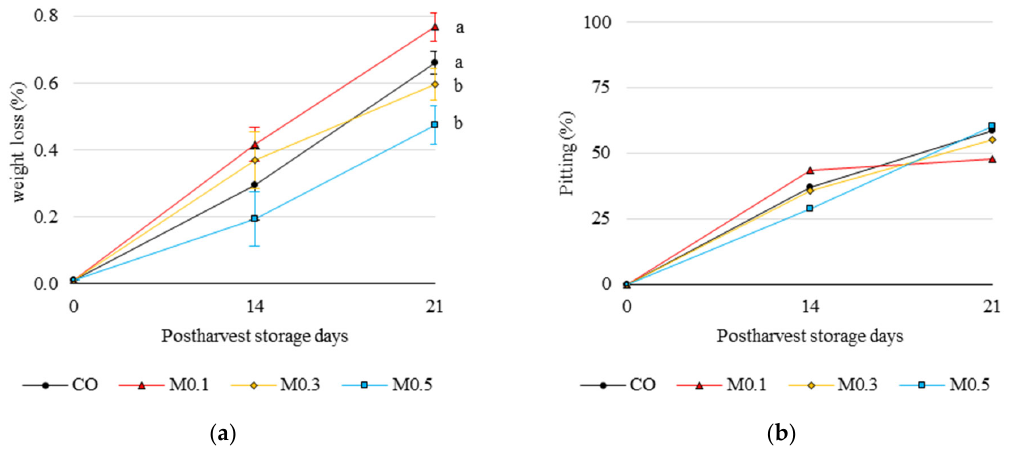
Figure 3. ( a ) Weight loss (%) of ‘Samba’ cherries in relation to treatments and storage time. ( b ) Pitting (%) of ‘Samba’ cherries in relation to treatments and storage time. Mean values ± SE ( n = 3). By storage time, di ff erent le tt ers indicate signi fi cant di ff erences between treatments by Tukey’s test ( p ≤ 0.05).